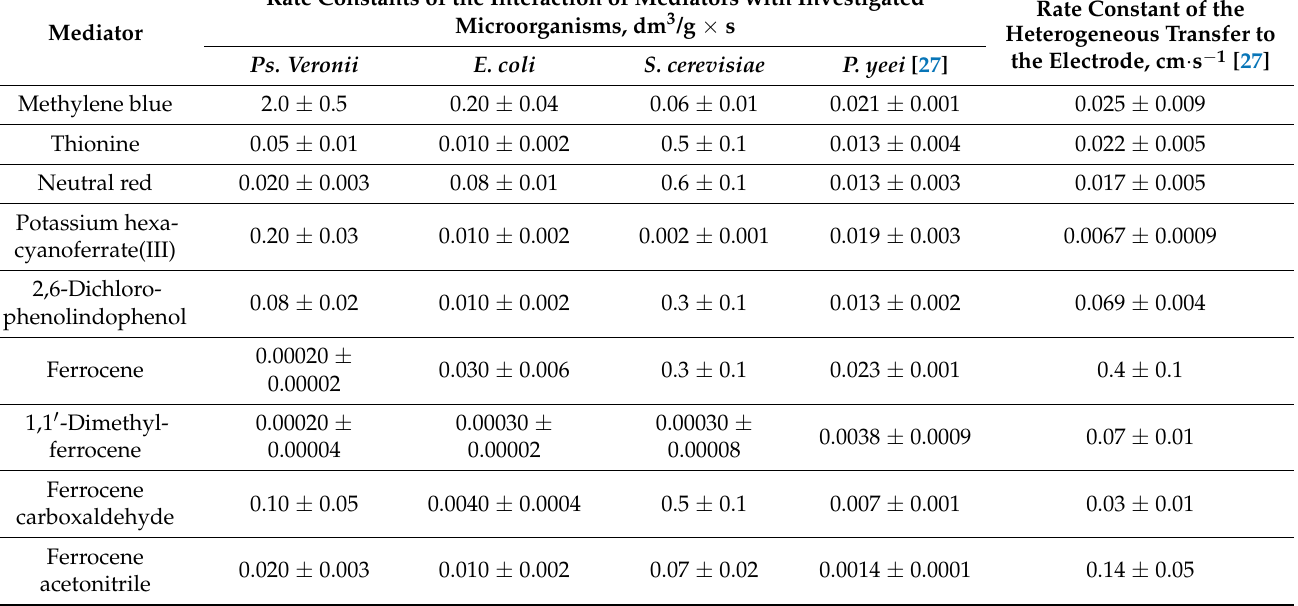
Table 1. The rate constants of the interaction of electron-transport mediators with investigated microorganisms and the rate constant of the heterogeneous transfer of electrons to the electrode. Mediator